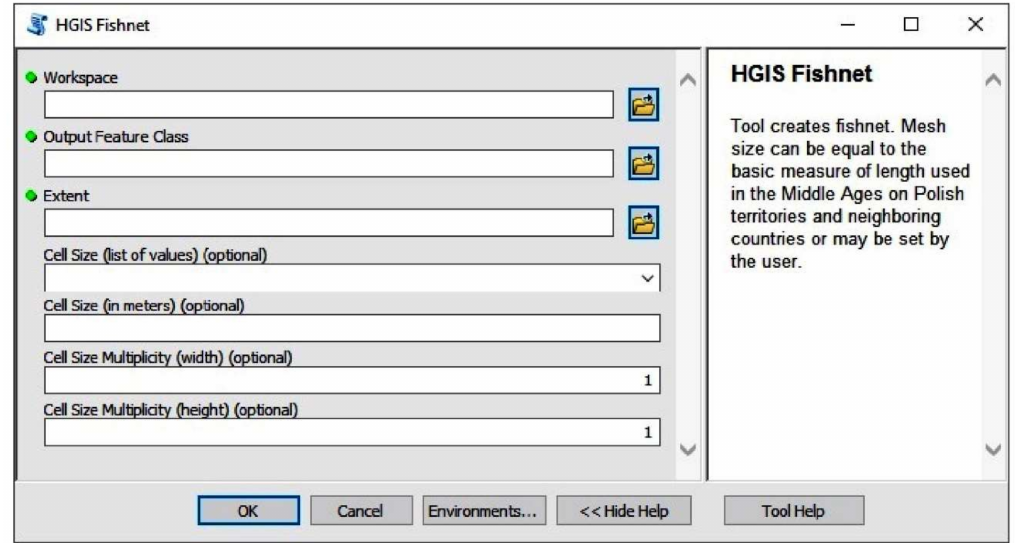
Figure 3. Description of the HGIS Fishnet tool interface